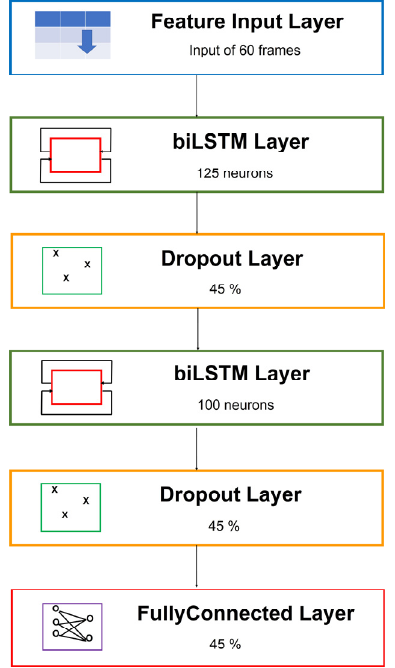
Figure 8. Definitive architecture of 2BLSTM2D model.